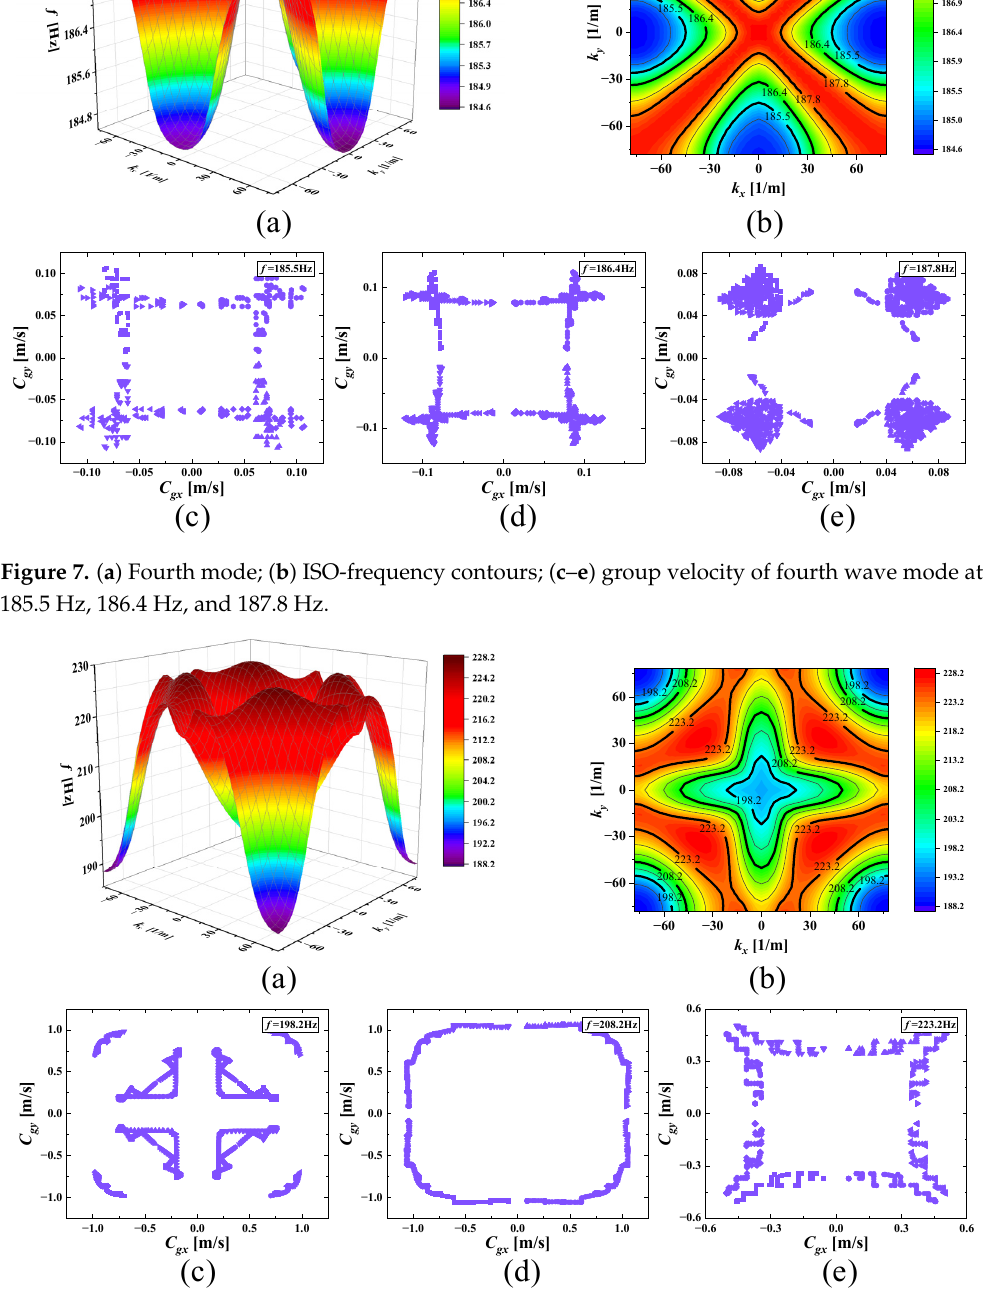
Figure 8. ( a ) Fifth mode; ( b ) ISO-frequency contours; ( c – e ) group velocity of fifth wave mode at 198.2 Hz, 208.2 Hz, and 223.2 Hz.